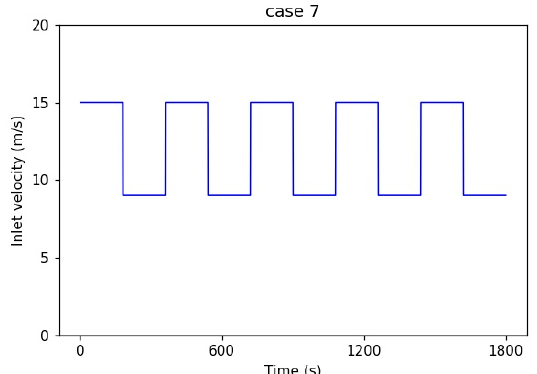
Figure 10. Optimized velocity pattern for the ventilation and methane removal strategy.